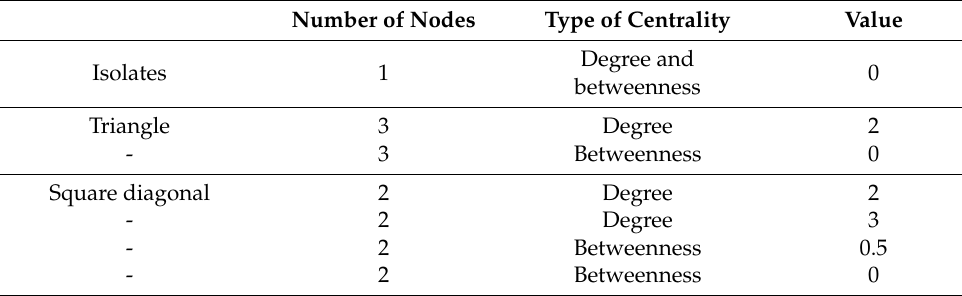
Table 1. Centrality values of fixed